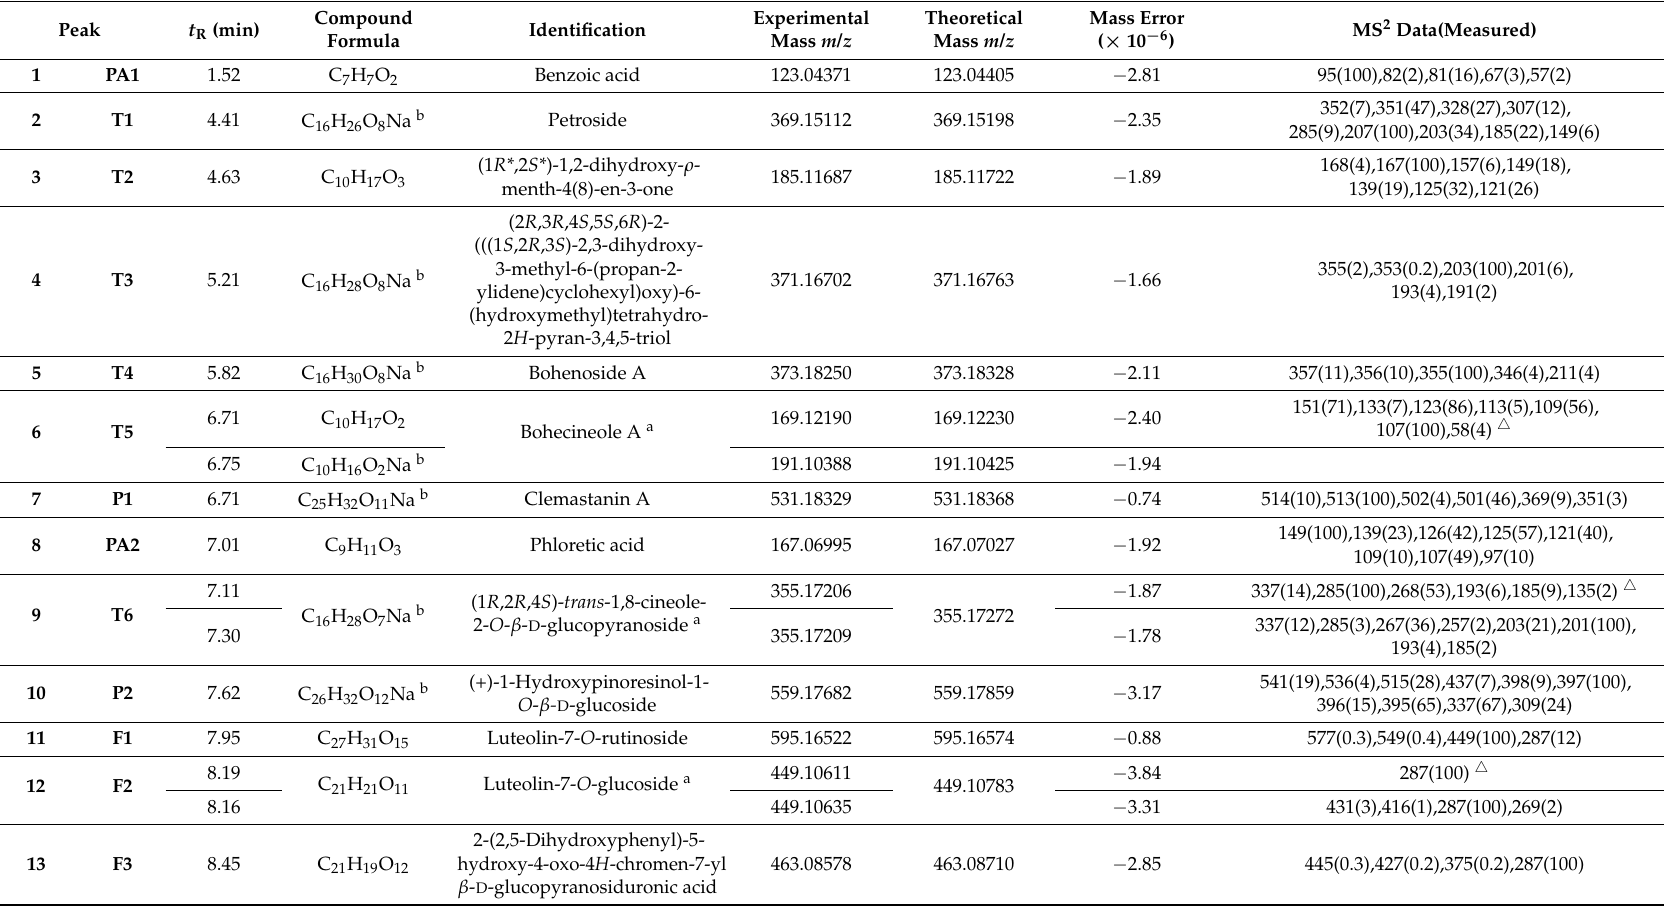
Table 1. Summary of chemical constituents identified in Menthae Haplocalycis herba by